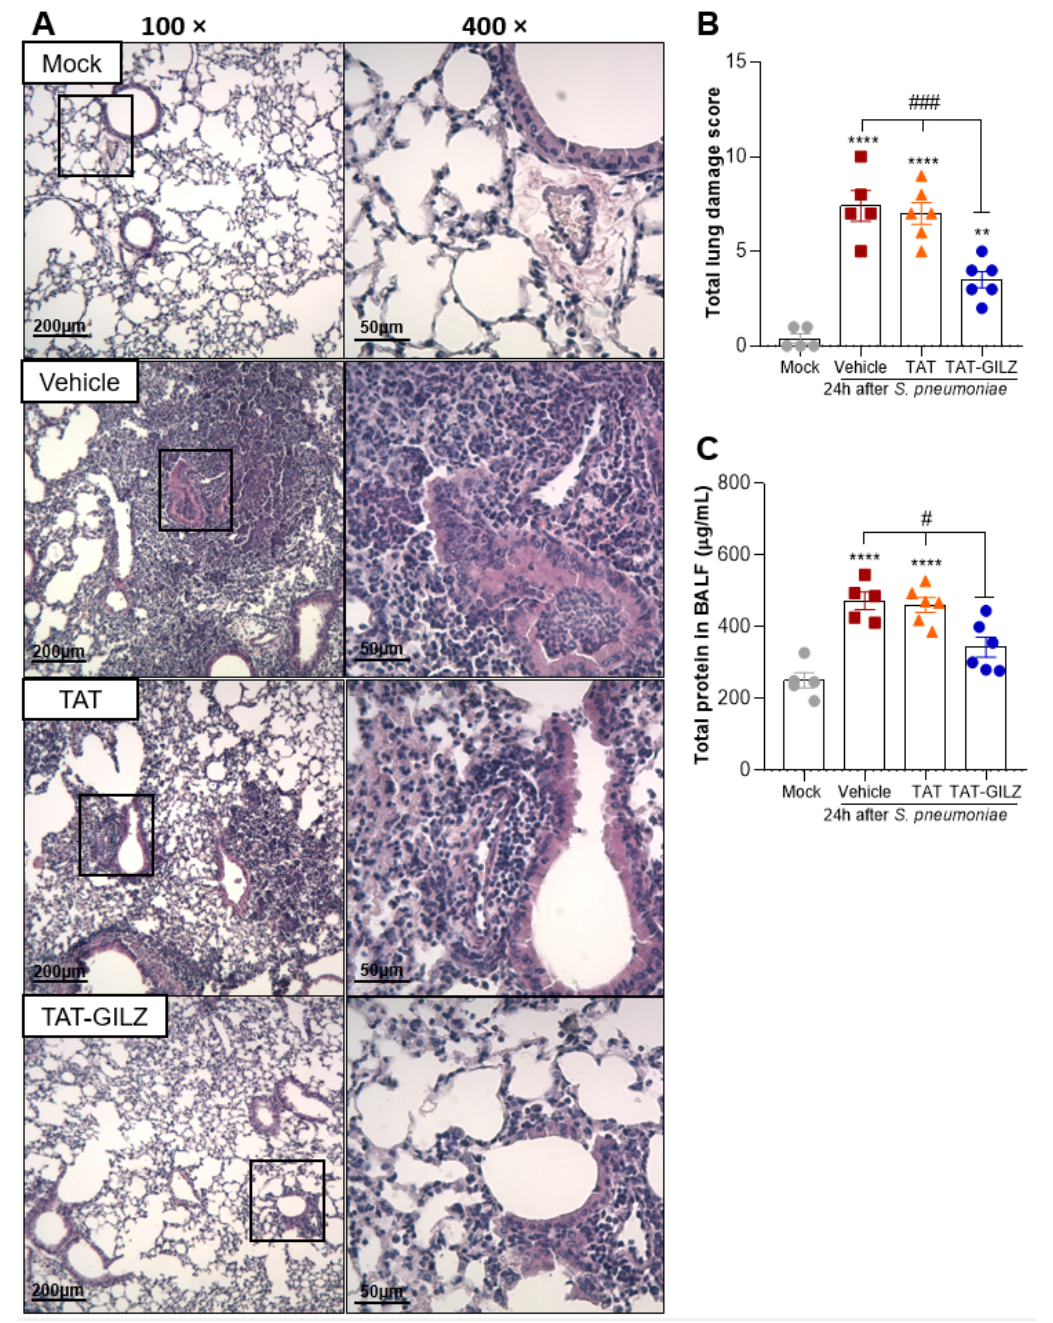
Figure 5. Effect of treatment with TAT-GILZ in lung damage caused by pneumococcal infection. BALB/c mice were infected with S. pneumoniae (1 × 10 5 CFU, i.n.), and then treated with TAT (0.1 mg/kg, i.p.) or TAT-GILZ (0.2 mg/kg, i.p.) 12 h p.i., and euthanized 24 h p.i. Mock group (uninfected) received salina and vehicle group received DMSO 0.6%. Representative slides of hematoxylin and eosin (H&E) stained lungs are shown ( A ). Scale bars = 200 μ m (low magnification) and 50 μ m (high magnification). Right slides are higher magnifications (400×) of the selected areas (boxes) in left slides (100×). Histopathological score evaluated airway, vascular, and parenchymal inflammation, neutrophilic infiltration, and epithelial injury ( B ). The total protein level in BAL is show in ( C ). Data are mean ± SEM of N = 5–6 animals per group. ** p < 0.01, **** p < 0.0001 when compared to mock group, or as indicated: # p < 0.05, ### p < 0.001 when comparing TAT-GILZ-treated pneumococcal pneumonia mice to vehicle or TAT groups, by 1-way ANOVA.